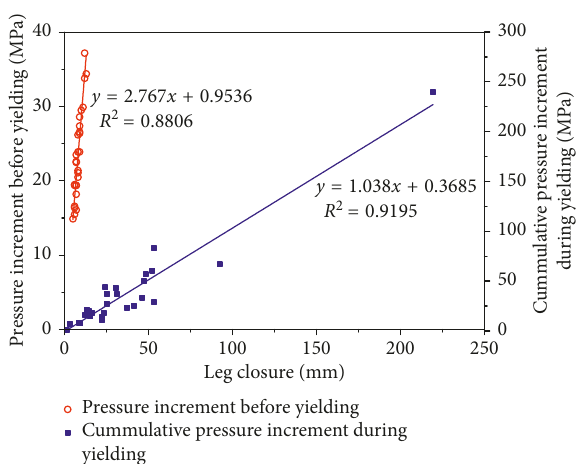
Figure 11: Leg pressure increment versus leg closure during and before yielding.